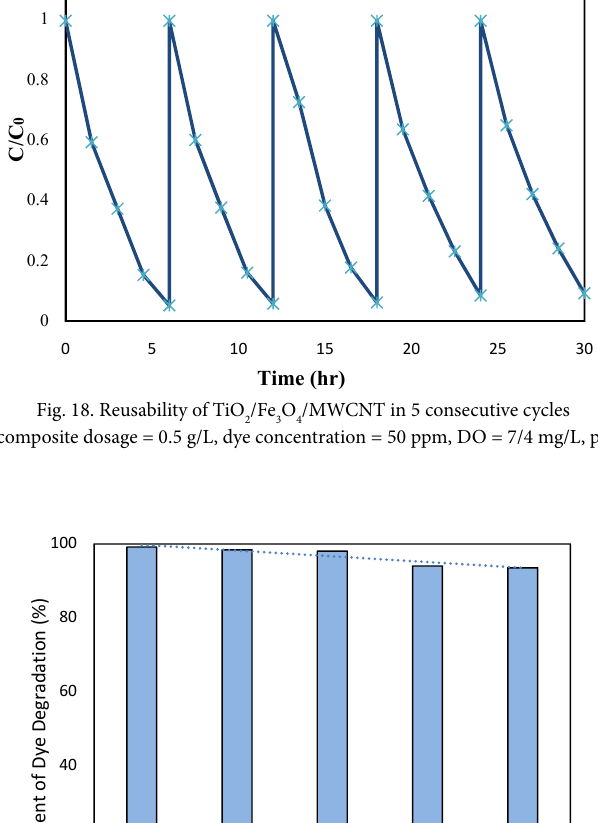
Fig. 19. The removal efficiency of acid red 14 after 6 hours in 5 consecutive cycles Nanocomposite dosage = 0.5 g/L, dye concentration = 50 ppm, DO = 7/4 mg/L, pH= 7) (